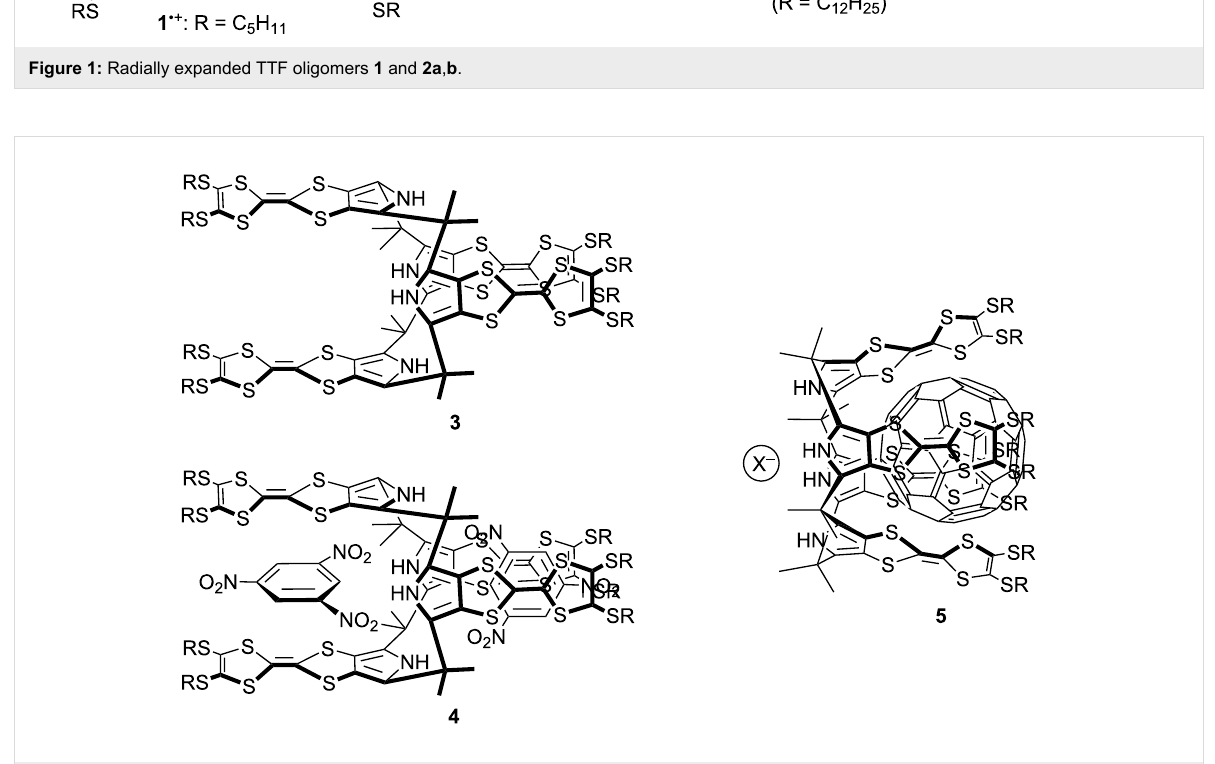
Figure 2: TTF-calix[4]pyrrole 3 and its TNT and C 60 complexes 4 and 5